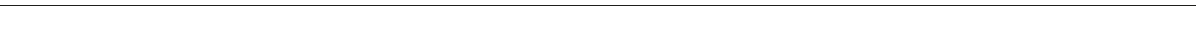
Fig. 9 Schematics of the correlation between Li – Si electrochemical/structural characteristics and Coulombic ef fi ciency. a Legend of six different Li – Si local environments upon (de)lithiation, which are used in ( b , c ). Fully delithiated amorphous (a-)Si and c-Li 3.75 Si are further subcategorized, according to the electrochemical and various atomistic structural probing results listed in Fig. 1. b Schematics of structural characteristics seen in two different electrochemical Li – Si reaction regimes. The dotted and solid arrowed axes at top show the asymmetric and symmetric regimes over cycle, respectively, the duration of which is signi fi cantly altered by the depth of discharge (DOD) control. The crossed empty squares embedded in the lines show the structural probing points inserted every 20 cycles. The shifts of the structural characteristics seen at these points in each regime are synchronized with the electrochemical regime shift. Firstly, the reaction fl ow of the Li – Si local environments also changes from asymmetric to symmetric, which is overlaid with the electrochemical processes. Secondly, the properties of Si – Si bonding and the morphology in a-Si are altered. Thirdly, the c-Li 3.75 Si crystal size is saturated at the shift. Finally, the electrode thickness also saturates near the shift. c Pro fi les of the local Li – Si environments at various potential during (de) lithiation over cycling under different DOD controls. The phases formed on lithiation and delithiation are shown on the left and right sides along blue and red arrows, respectively. The constant voltage domain at 10 mV is illustrated by black arrows. Each component in the pie charts shows a local environment present at the given potential, while their sizes indicate the relative proportion of the phases. The dotted and solid lines in cycle number and CE pro fi les indicate the asymmetric and the symmetric regimes, respectively. The local environments and their pro fi les on (de)lithiation signi fi cantly depend on the af fi liated electrochemical regimes, which consequently governs CE pro fi les. The af fi liation and CE behaviors can be prominently altered by the repeated a – c phase